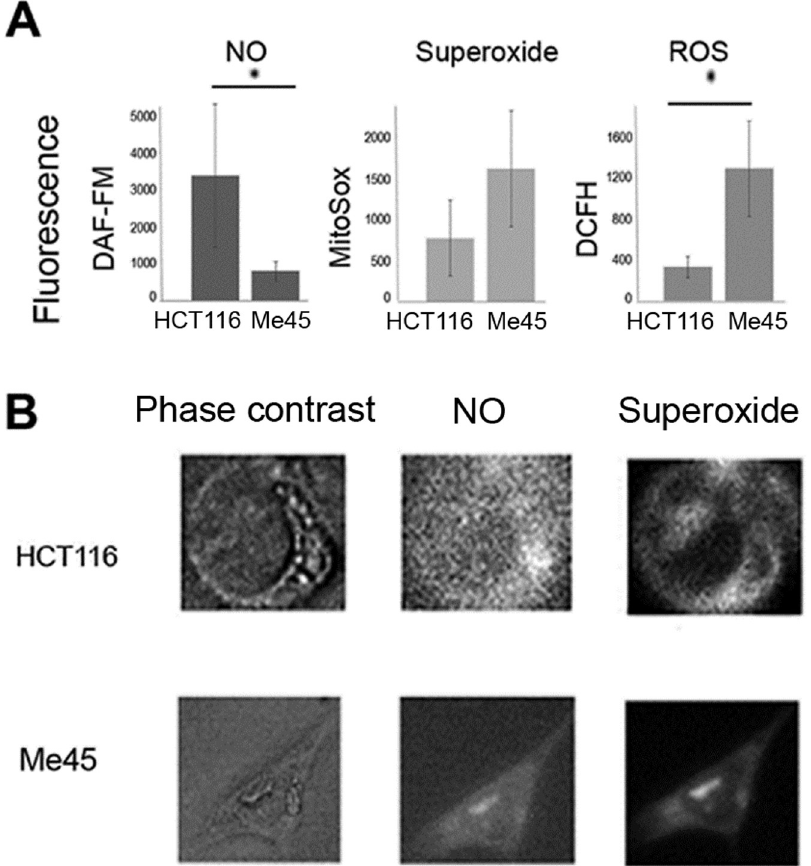
Fig 4. Nitric oxide and ROS in HCT116 and Me45 cells. A; mean levels of NO, superoxide and ROS detected by DAF-FM, MitoSOX Red and DCFH-DA respectively, measured in whole population of unirradiated cells by flow cytometry (data presented as a mean with a standard deviation from 4 experiments; statistically significant differences (p < 0.05) were marked with an asterisks), B; examples of superoxide and NO distribution in single HCT116 and Me45 cells observed by fluorescence microscopy, NO detected by fluorescence of DAF-FM diacetate and superoxide by MitoSOX Red.